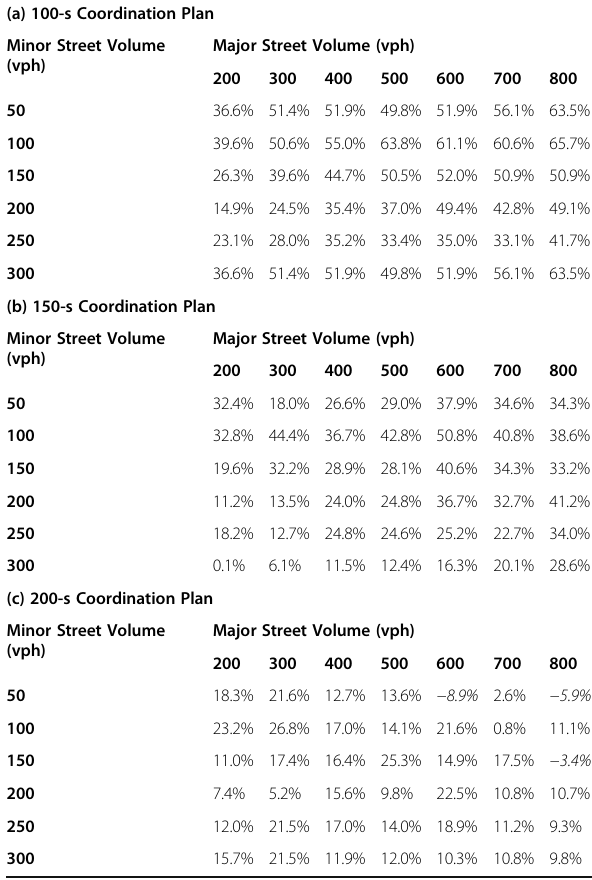
Table 3 Comparison of Simulated Number of Conflicts between Coordinated Signal Plans and Free Signal Operation Scheme at Pyramid Way Percent of Improvement in Number of Conflicts after Implementing Signal Coordination (a) 100-s Coordination Plan Minor Street Volume (vph)